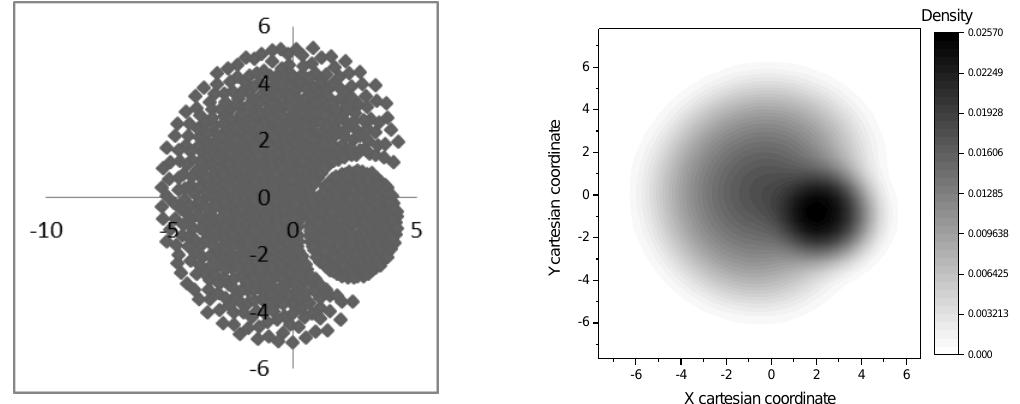
Figure 9. RECAP cluster analysis (left); cluster point to point representation (cluster density – right).